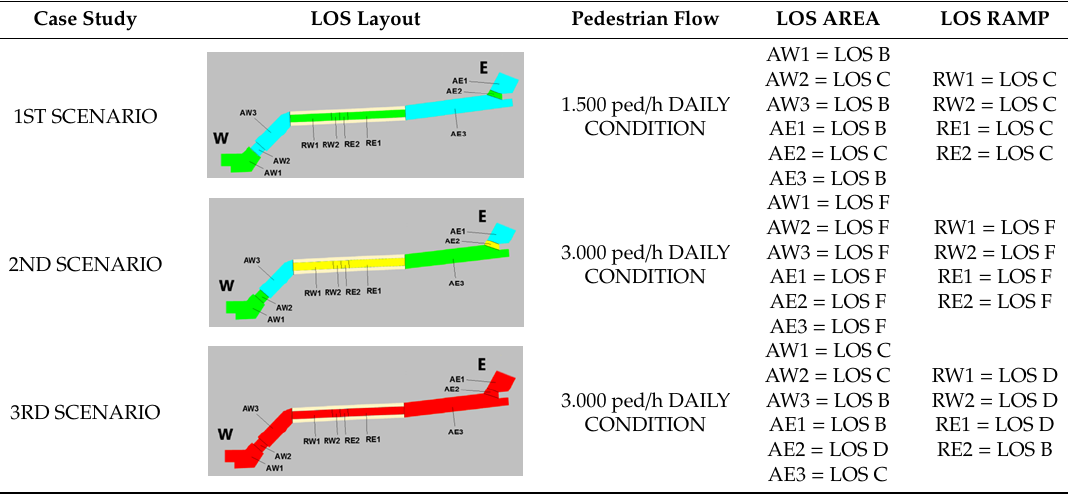
Table 9. LOS comparison considering ramp W and E for each scenario.